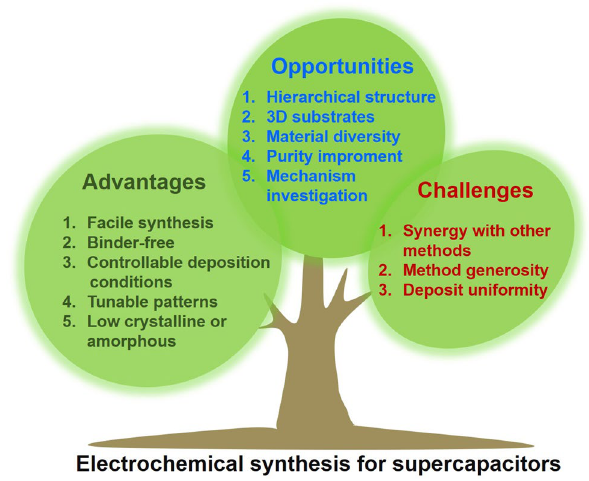
Fig. 33 Advantages, challenges, and future opportunities of electro‑ chemical synthesis for